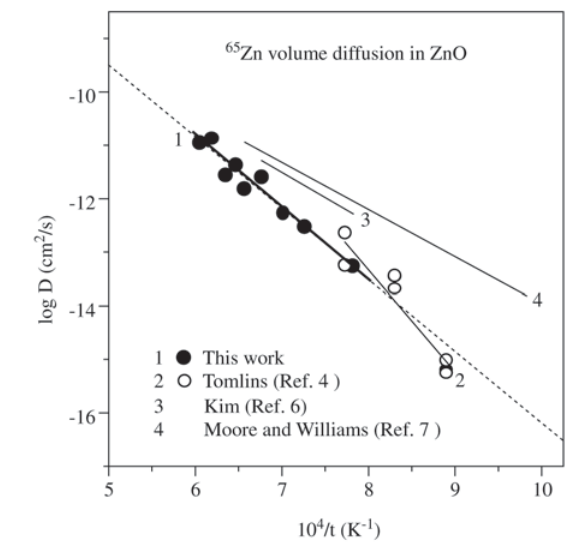
Figure 2. Diffusion profile for the isotope 65 Zn in ZnO polycrystal at 1300 °C.